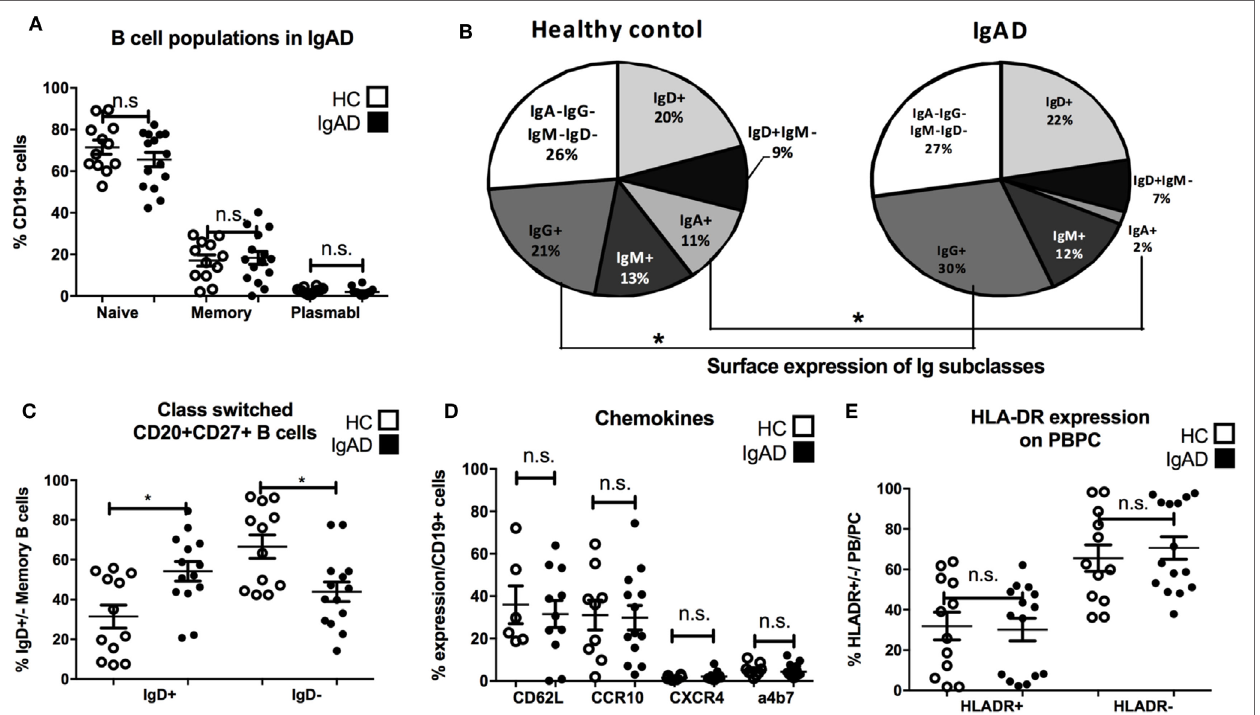
FigUre 1 | B cells in IgA-deficient individuals lack IgA, but have increased IgG surface expression. The figure shows B cell populations as measured by flow cytometry comparing selective IgA deficiency (IgAD) donors to healthy controls (HC). (a) Percentage of naïve (CD20 + CD27 − ), memory (CD20 + CD27 + ), and plasmablasts (CD20 − CD27 + ) as % of CD19 + B cells are shown. No significant differences are seen for these populations between IgAD and HC. (B) Representative pie chart for frequencies of Ig isotypes expressed on total CD19 + B cells in IgAD and HC donors. The fraction is reduced for IgA ( p < 0.0009) positive B cells and increased for IgG ( p < 0.029) positive B cells in IgAD compared to HC. (c) The percentages of class-switched (CD20 + CD27 + IgD + ) memory CD19 + B cells in IgAD individuals and HC. IgAD donors have significantly less class-switched memory B cells. (D) The proportion of CD19 + B cells expressing chemokines associated with gut homing; CD62L, α 4 β 7, CCR10, and CXCR4, is comparable in IgAD individuals and HC. (e) The activation of plasmablasts/plasma cells in IgAD evaluated by percentage of HLA-DR expression shows comparable activation in IgAD and HC. All data are from five-independent experiments, no duplicates. Significance was calculated in relation to control group determined by one-way ANOVA. * p < 0.05, ** p < 0.01, *** p <